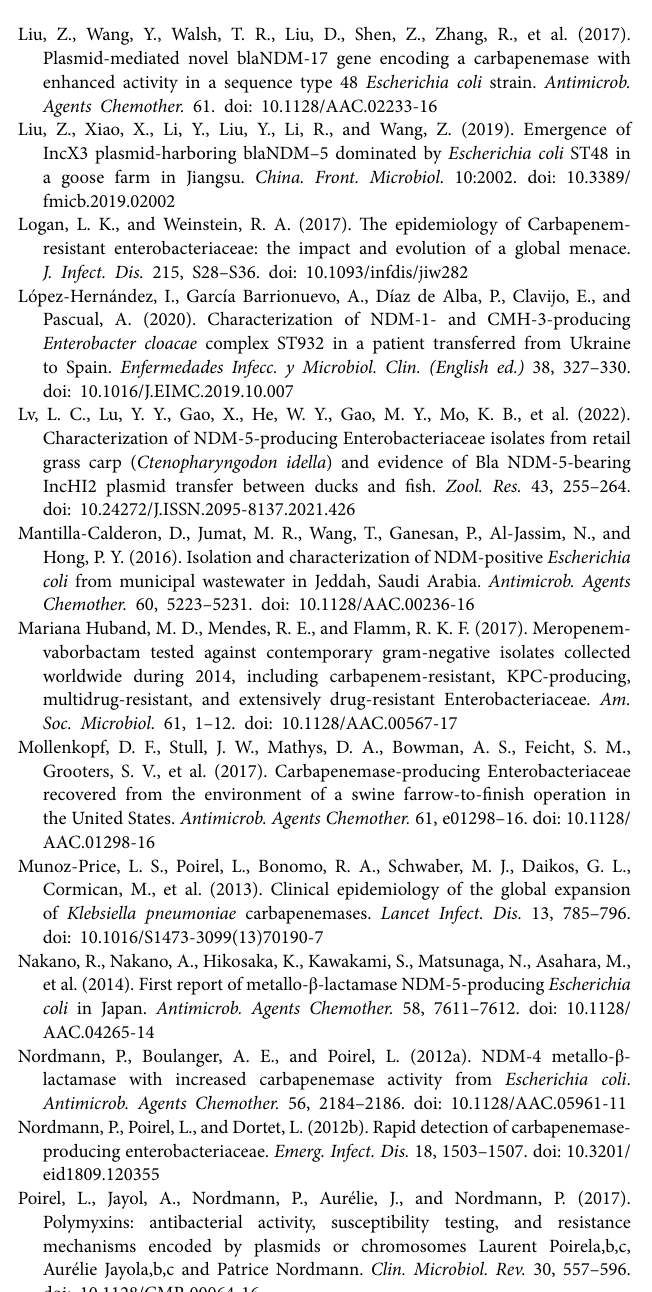
SUPPLEMENTARY FIGURE S1 | PFGE analysis of 77 bla NDM -positive Escherichia coli isolates from food-producing animals. Triangles represent that the corresponding isolates sharing similar PFGE